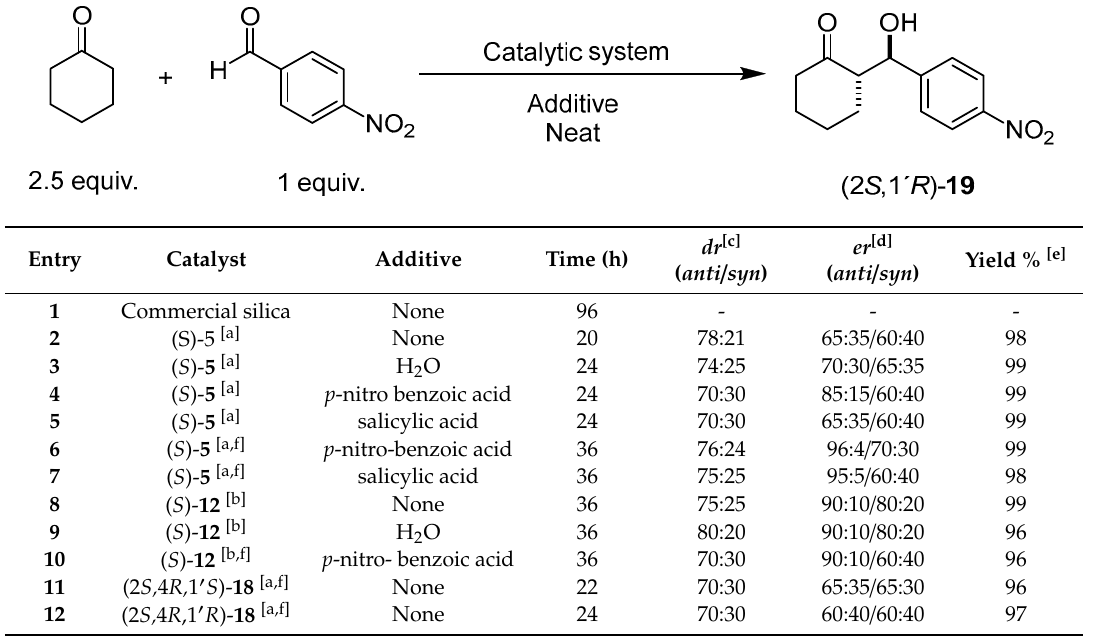
Table 1. Asymmetric aldol reaction between cyclohexanone and 4-nitrobenzaldehyde in the presence of organocatalysts ( S ) -5 , ( S ) -12 , (2 S ,4 R ,1 (cid:48) S ) -18 and (2 S ,4 R ,1 (cid:48) R ) -18 .